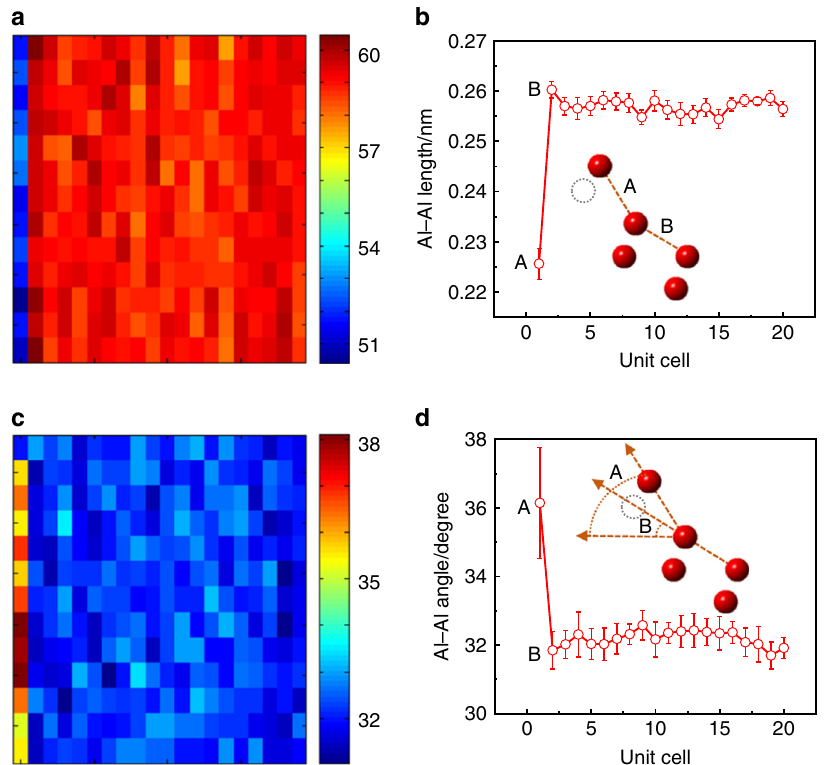
Fig. 3 Quantitative measurements of Al – Al length and angle. a Al – Al length mapping. b Averaged distance. c Al – Al angle mapping. d Averaged angle. The error bars are the standard deviation